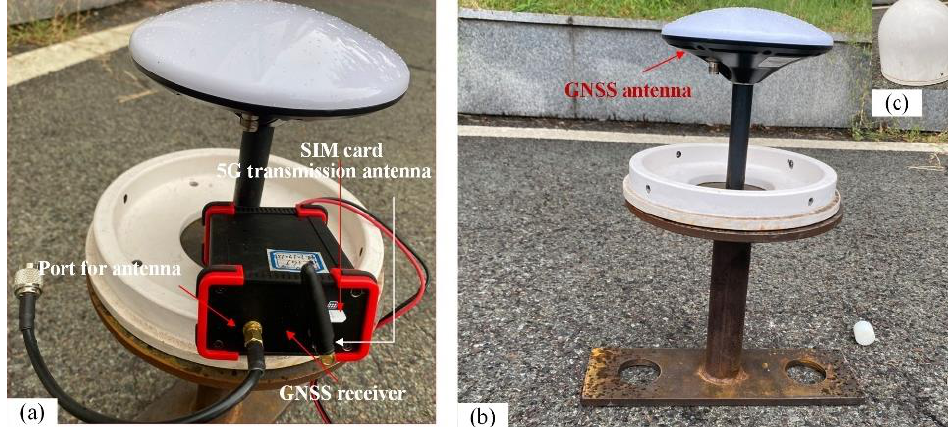
Figure 6. Low-cost GNSS receiver equipment. ( a ) Details of low-cost GNSS. ( b ) Installation of antenna equipment connects the antenna and main cable. ( c ) GNSS antenna dome.